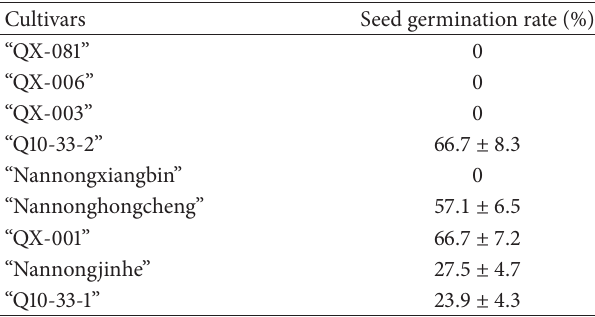
Table 2: Germination rate of selfing